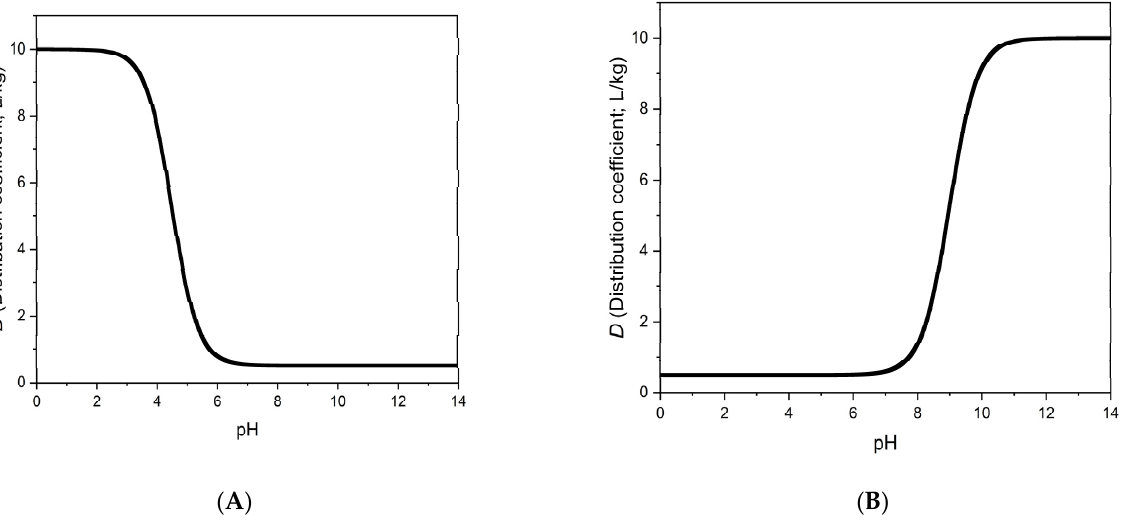
Figure 1. ( A ) shows the pH dependence of D , based on Equation (5) and assuming that K a = 1 ×10 − 4.5 , K HA = 10, and K A = 0.5. The figure shows that at pH values much lower than p K a (which is 4.5 in the present case), the distribution coefficient is D = K HA , while at pH values well above the pK a , it is D = K A . The parameters chosen for ( A ) might represent a weak acid. With parameters that might represent a weak base ( pK a = 9.0, K HA = 0.5, and K A = 10), one obtains the curve of ( B ). In either case, if the ionic form were not extracted, then its K value would be zero, and the curve would also go down to zero in the corresponding pH range.